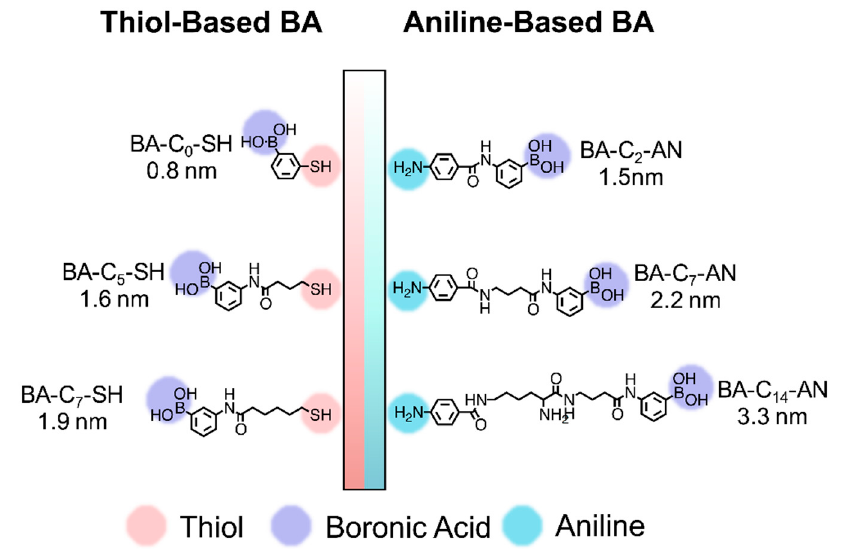
Figure 1. Derivatives of the BA spacer: aniline-based BA modified through electrodeposition and the thiol-based BA modified through SAM on a QCM chip.